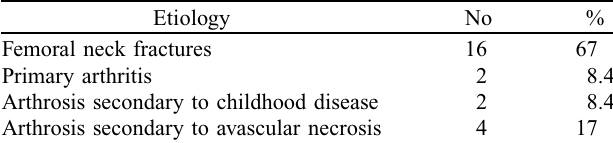
Table 1. Indications for surgery in the study group.